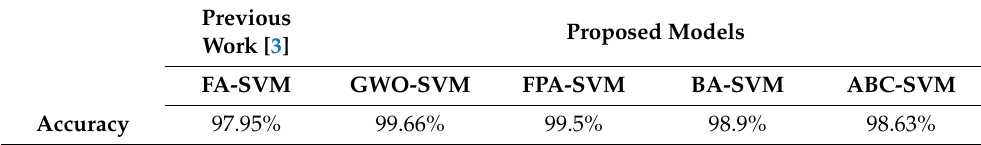
Proposed Models